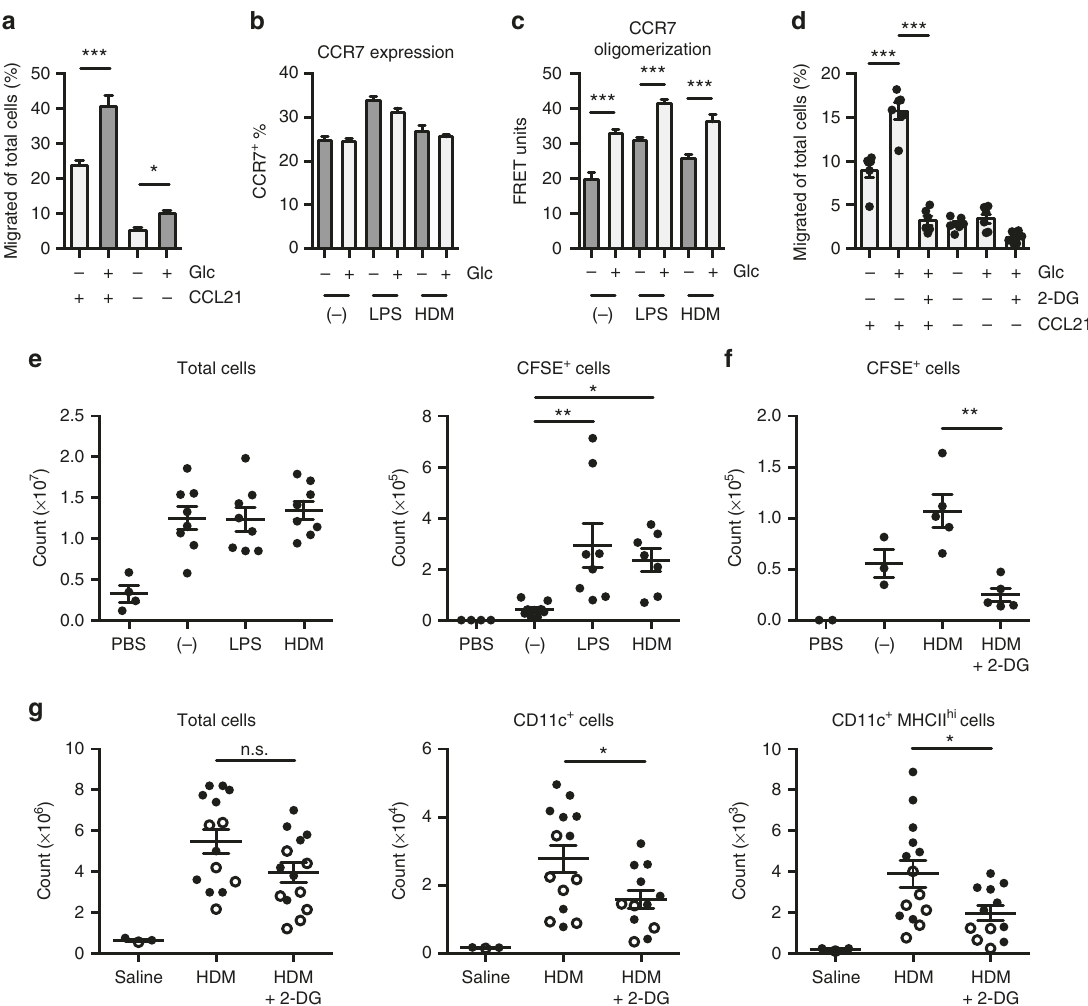
Fig. 6 Inhibition of glycolysis impairs CCR7 oligomerization and reduces DC migration to the draining lymph node. a DCs incubated with or without 10 mM glucose for 4 h migrate toward CCL21 for 2 h. b Total CCR7 expression levels were measured and c CCR7 oligomerization was determined by FRET of DCs left unstimulated or stimulated with LPS or HDM with or without 10 mM glucose for 6 h. d DCs isolated from the spleen were cultured with or without 10 mM glucose or 2-DG for 6 h, then migrate toward CCL21 for 2 h. e CFSE-labeled DCs stimulated were injected subcutaneously into the footpads of mice and the popliteal LNs were harvested after 45 h. Total cell number (left) and CFSE + cells (right) from dLNs were determined. f CFSE-labeled DCs were stimulated with HDM with or without 10 mM 2-DG prior to footpad injection and LN harvest as in e . g Cell numbers from mediastinal LNs of mice treated i. n. with 40 μ g HDM or saline, and i.p. with 2-DG or saline. Data in a – c are from one experiment representative of three experiments (mean and s.d. of triplicates). Data in d and e are from two experiments (mean and s.e.m. of 6 mice ( d ), 4 mice for PBS control and 8 mice for other conditions ( e )). Data shown in f are from one experiment representative of three experiments (mean and s.e.m. of 2 mice (PBS), 3 mice (unstimulated), or 4 – 5 mice (other conditions)). Data in g are from two experiments, with closed and open circles representing mice from different experiments (mean and s.e.m. of 3 mice for saline control and 14 mice for other conditions). Data were analyzed using one-way ANOVA. *** p < 0.001, ** p < 0.01, * p <